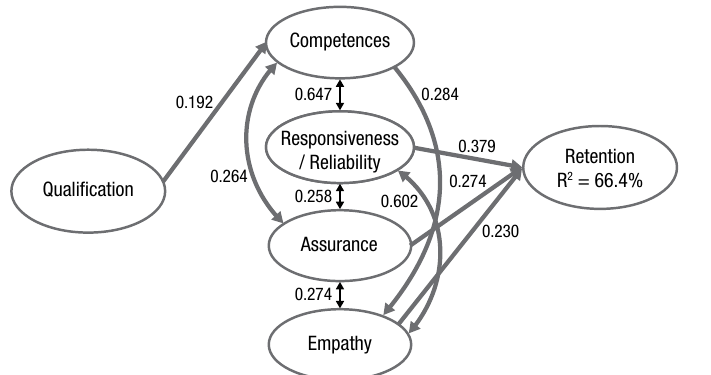
Fig. 2. Estimated path coefficients in the structural model Note: Only significant paths of the main variables are depicted. Double arrows indicate that associations were also tested in the reverse direction. Results are robust and, for brevity, not